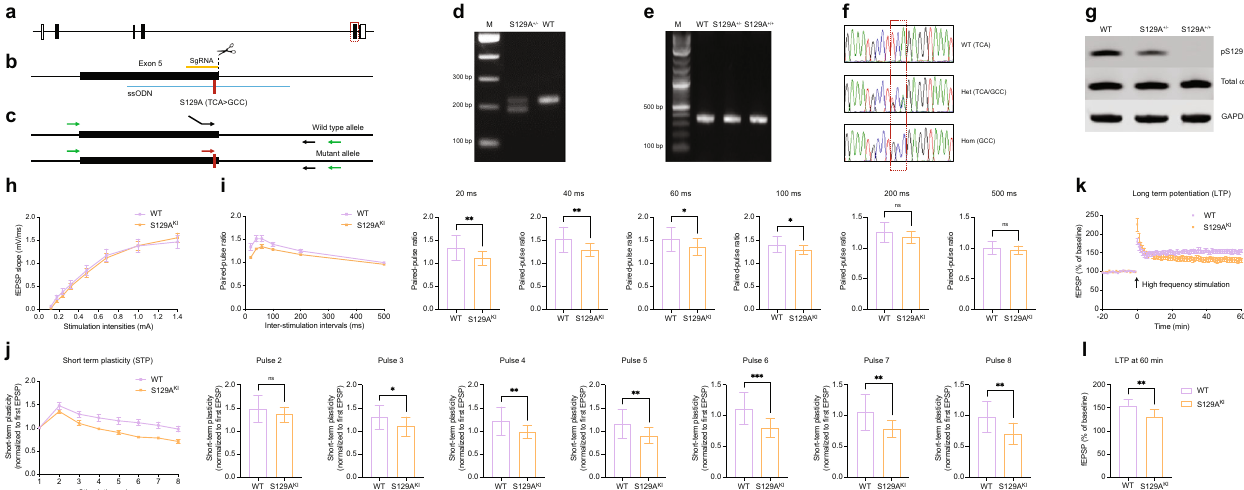
Fig. 7 Synaptic plasticity is impaired in S129A KI mouse. a – f Generation of the S129A knock-in mutation in mice. a Genomic structure of the mouse SNCA gene. Exons are depicted after transcript variant SNCA-201 (ENSMUST00000114268.5), with coding and non-coding regions shown as fi lled or open boxes, respectively. Exon 5 is boxed with red dashed line. b A knock-in strategy using CRISPR-Cas9 and ssODN was employed to generate the S129A mutation in Exon 5 of the endogenous SNCA gene. Relative positions of sgRNA (orange horizontal line), ssODN (blue horizontal line), and the S129A mutation (red vertical line) are indicated. c – f ES cell clone screening and mouse genotyping. A 3-primer PCR strategy (primers indicated with black and red arrows) was designed to distinguish WT and mutant alleles ( c , d ). For genotyping, a common pair of primers (indicated with green arrows) was used for PCR followed by sequencing to distinguish different genotypes ( c , e , f ). g Total mouse brain homogenates from indicated genotypes. WB for total α S, pS129 (D1R1R) and GAPDH. h Input and out current curve from hippocampal slices (CA1 region) of indicated mouse genotypes. N = 3 animals each, n = 16 (WT) or 17 (S129A KI ) individual slices. i Paired- pulse facilitation of WT and S129A KI hippocampal slices. Inter-stimulation intervals as indicated. N = 3 animals each, n = 16 (WT) or 17 (S129A KI ) individual slices. Unpaired t -tests for 20, 40, 60, 100, 200, and 500 ms with Welch ’ s correction; two-tailed; mean ± SD; ns not signi fi cant; * p < 0.05; ** p < 0.01. j Short-term plasticity assessed by multi-pulse events. Values normalized to fi rst excitatory post synaptic current (EPSP). N = 3 animals each, n = 16 (WT) or 17 (S129A KI ) individual slices. Unpaired t -tests for pulses 2, 3, 4, 5, 6, 7, and 8 with Welch ’ s correction; two-tailed; mean ± SD; ns not signi fi cant; * p < 0.05; ** p < 0.01; *** p < 0.001. k , l Long Term Potentiation (LTP) of WT and S129A KI . LTP induced by standard 100 Hz stimulation. N = 3 animals each, n = 8 (WT) or 10 (S129A KI ) individual slices. Unpaired t -tests for panel l (values at 60 min from K) with Welch ’ s correction; two-tailed; mean ± SD; ** p < (Fig. 6h, i) to be unaltered between neurons expressing these two variants. In contrast, the respective amplitudes, which are mediated by postsynaptic receptor activation/inhibition, were signi fi cantly different between α S WT and α S S129A. In the case of sEPSCs, we observed a signi fi cant reduction in SNCA − / − neurons exogenously expressing α S S129A relative to SNCA − / − neurons complemented with α S WT (Fig. 6f, g). In the case of sIPSCs, conversely, we observed an increase in α S S129A-expressing